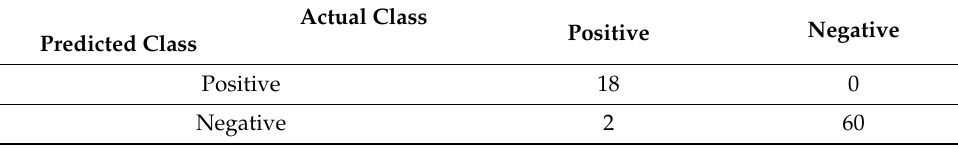
Table 9. Confusion matrix of expulsion occurrence prediction result.